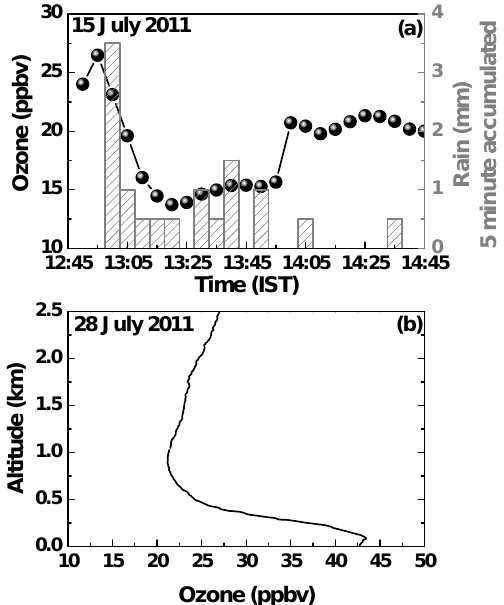
Figure 9. (a) Temporal variation in surface O 3 mixing ratio (black dots) along with 5min accumulated rainfall (grey vertical bars) over Thumba, Thiruvananthapuram (location of the site shown in Fig. 1), on 15 July 2011. (b) Vertical profile of O 3 mixing ratio over Thumba, Thiruvananthapuram, as measured on 28 July